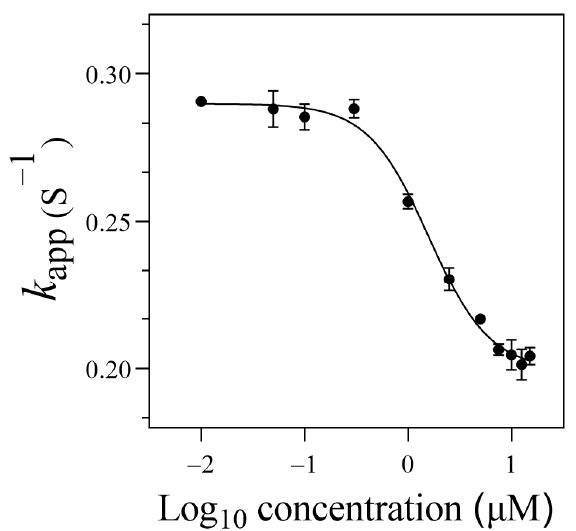
Figure 5. The binding curve of the SITS-Trombin27 5 ′ with thrombin.